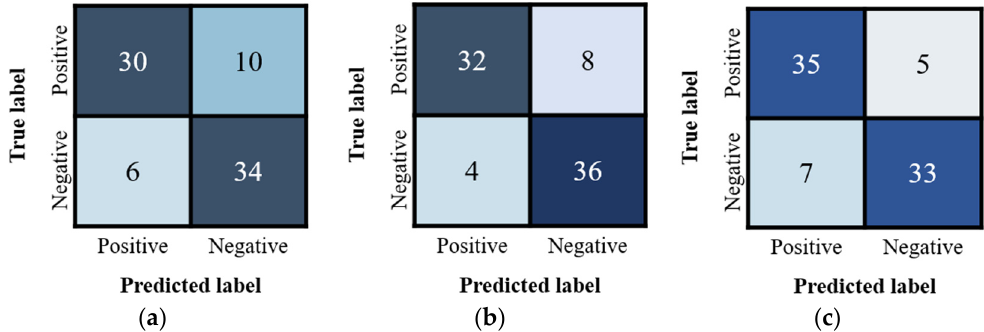
Figure 6. The confusion matrices of applying ( a ) Inception v4, ( b ) Inception-ResNet v2, and ( c ) DenseNet-121 on the 80 testing results.